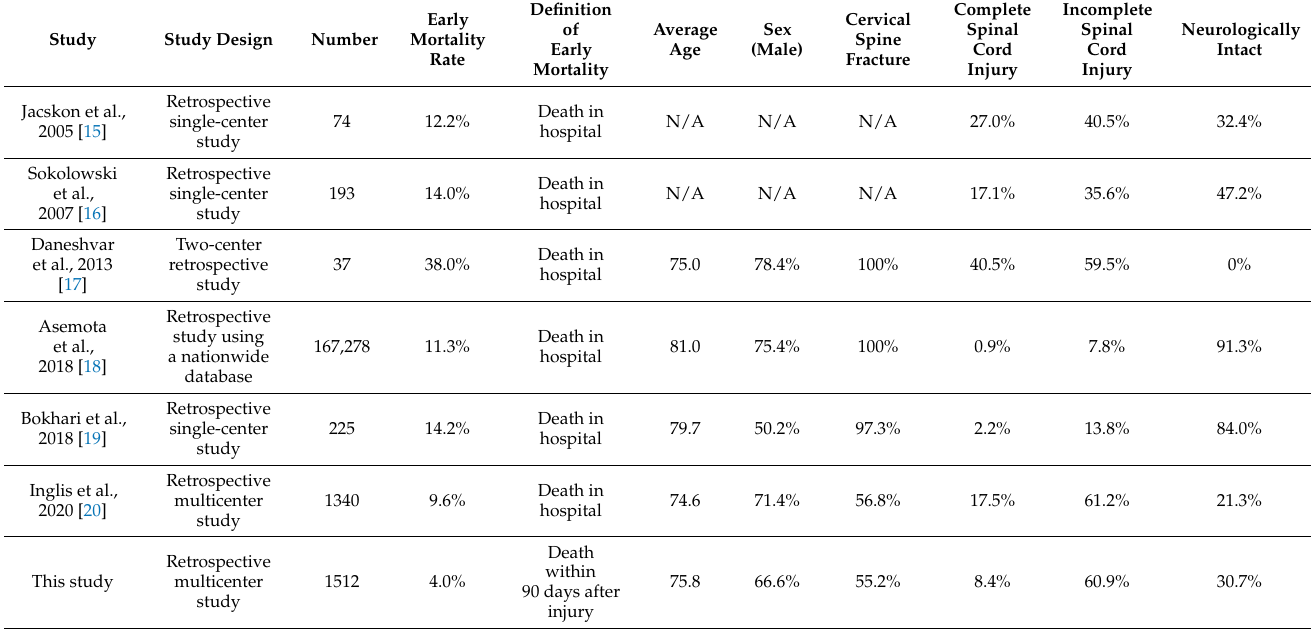
Table 5. Previous research focusing on early mortality after traumatic cervical spine injury in older